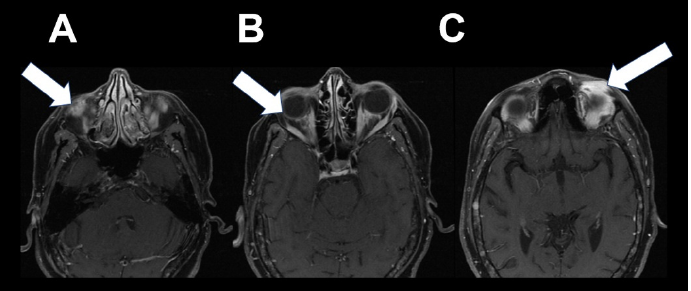
Figure 4. Post-contrast axial T1-weighted fat-saturated magnetic resonance images demonstrate bi- lateral ill-defined infiltrative enhancement involving the left superior ( C , arrow) and right inferior ( A , arrow) preseptal soft tissues extending into the superior extraconal fat, diffuse extraocular mus- cle enlargement and hyperenhancement ( B , arrow), consistent with underlying infiltrative orbital metastatic disease in the setting of known invasive lobular carcinoma.